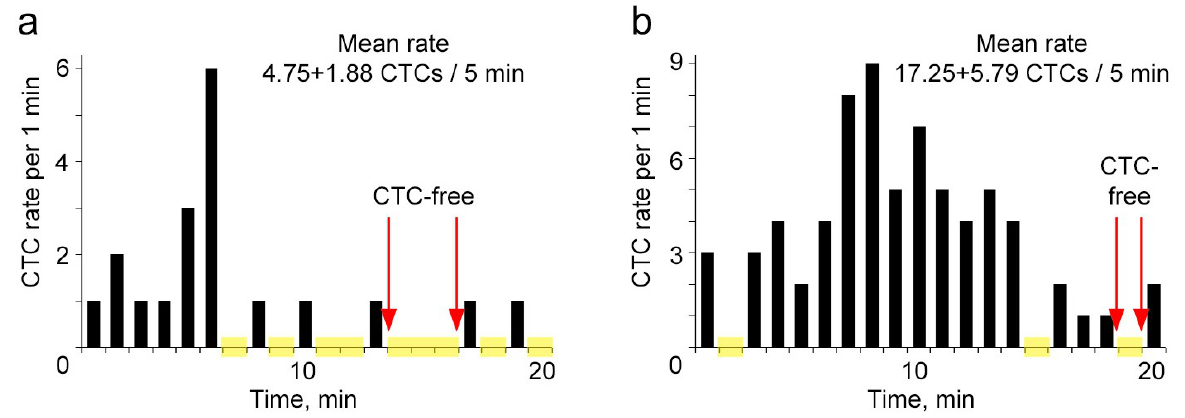
Figure 6. Real-time continuous PAFC monitoring of spontaneous CTCs in ≈200 µm blood vessels of mice with the primary melanoma tumor in the flank. ( a ) CTC number at week 1 after inoculation; ( b ) CTC number at week 2 after inoculation. Yellow squares show time intervals of CTC absence in a detection area. Laser parameters: 1,064 nm, 0.5 J/cm 2 , 10